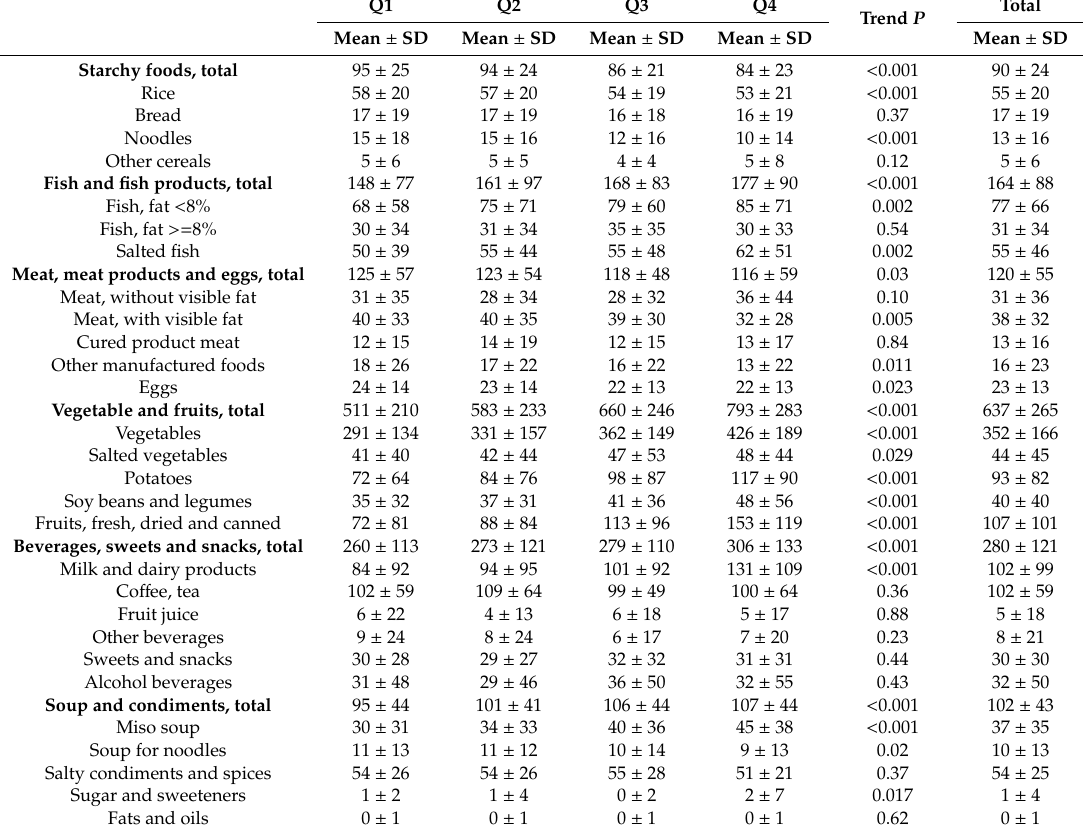
Table 4. Potassium intake (mg / 1000 kcal) from 29 food groups, participants stratified by quartiles